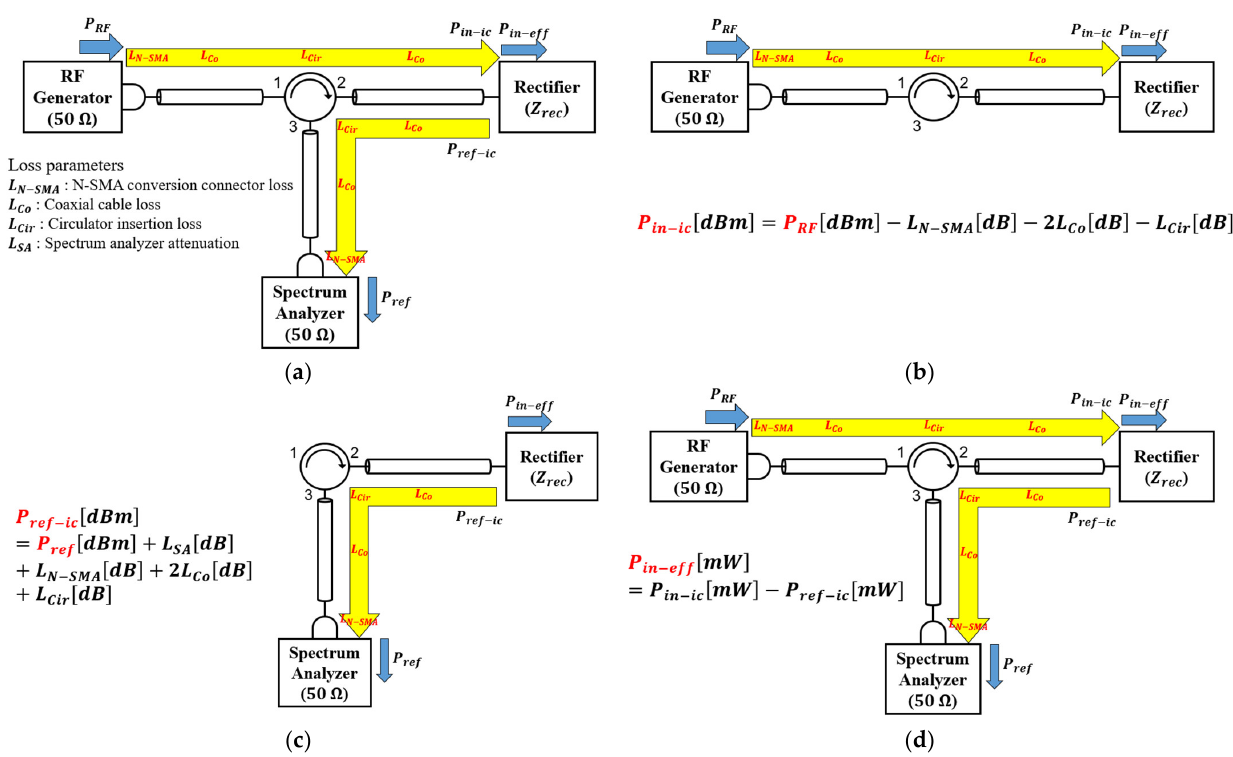
Figure 20. Calibration procedure of input effective power: ( a ) definition of loss parameters, ( b ) calculating the power that reaches the rectifier, ( c ) relationship between reflection power at connection point and measured power by spectrum analyzer, ( d ) equation of input effective power.